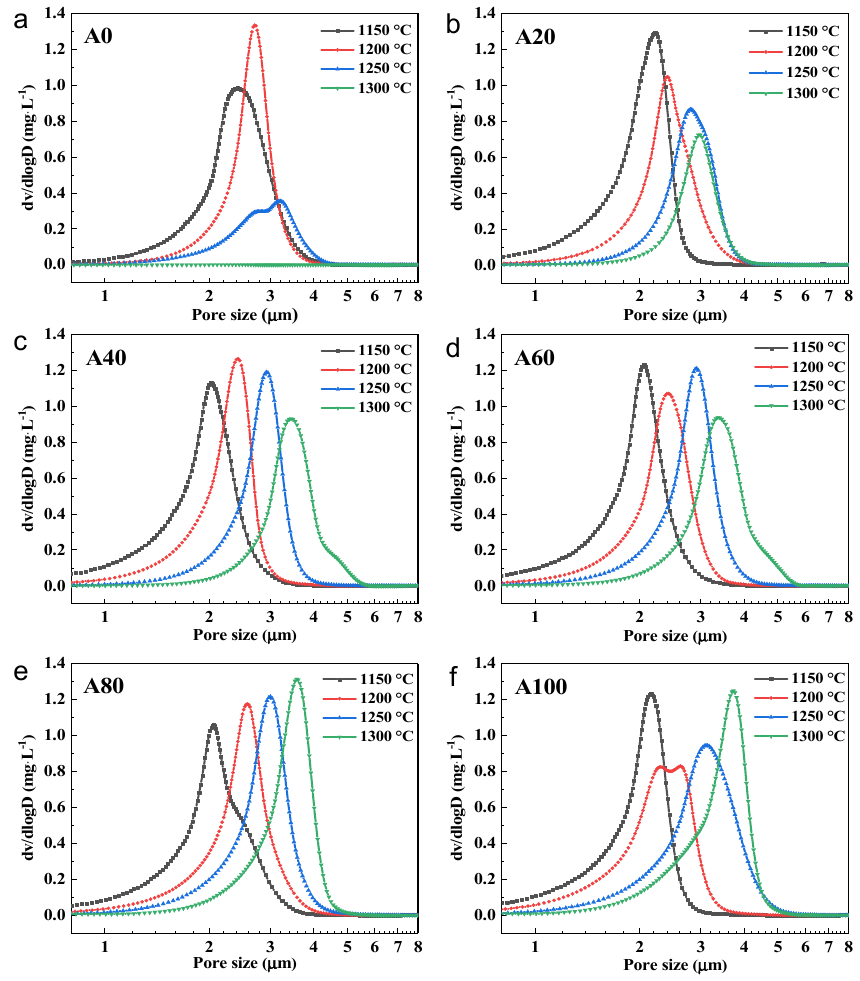
Figure 6. Pore size distribution of supports sintered at different temperatures for A0 ( a ), A20 ( b ), A40 ( c ), A60 ( d ), A80 ( e ), and A100 ( f ).